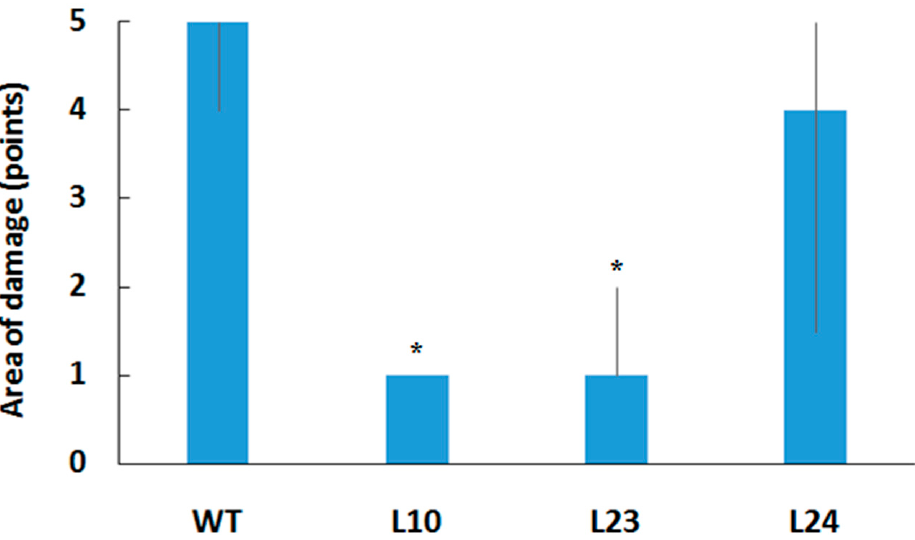
Figure 5. Resistance of leaves of tobacco plants transformed with VlvSTS gene to pathogenic bacteria E. carotovora . Extent of leaf damage 48 h post inoculation. Median, Q1 and Q3 are shown for the area of leaf damage scored from 0 to 5 points, 0 = no damage, 1 = 10–20% damage, 2 = 20–40%, 3 = 40–60%, 4 = 60–80%, 5 = 80–100%. * Statistically significant at Mann-Whitney test ( p < 0.05). 2.3. Trans-Resveratrol Content Assay in Leaves of the Tobacco Transgenic Line with the Highest Expression of the VlvSTS Gene Since the stilbene synthase gene is responsible for resveratrol synthesis in plants, we determined the content of this metabolite in the leaves of transgenic plants. This was ac- complished by high performance liquid chromatography-mass spectrometry analysis of leaf extracts derived from plants of the L10 tobacco line with the highest expression of the VlvSTS gene (Figure 6). The amount of trans-resveratrol in the leaves of TL was in a range